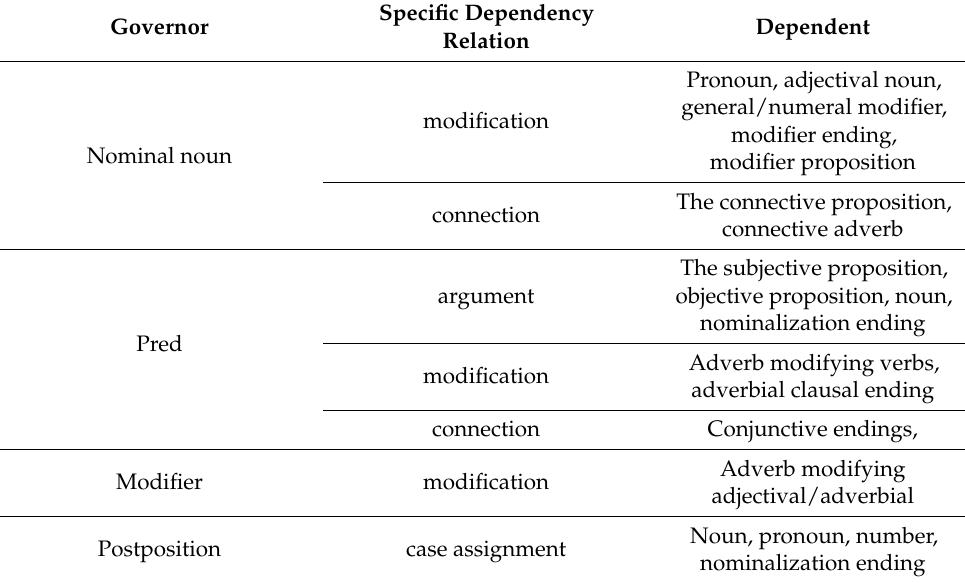
Table 9. Dependency relations between